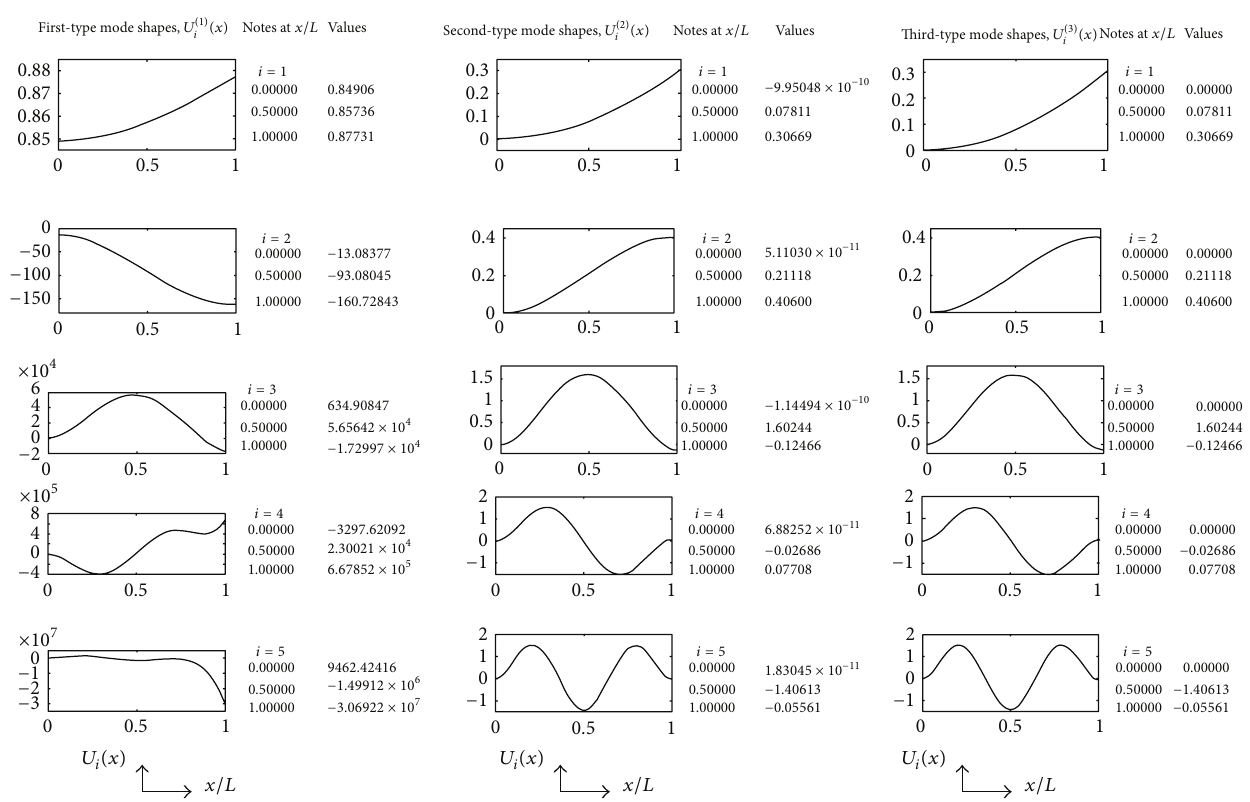
Figure 7: Three types of the first five mode shapes with the combinations of 𝜙 = 4 , 𝑘/𝐿 = 4 , and 𝑑/𝐿 = 2